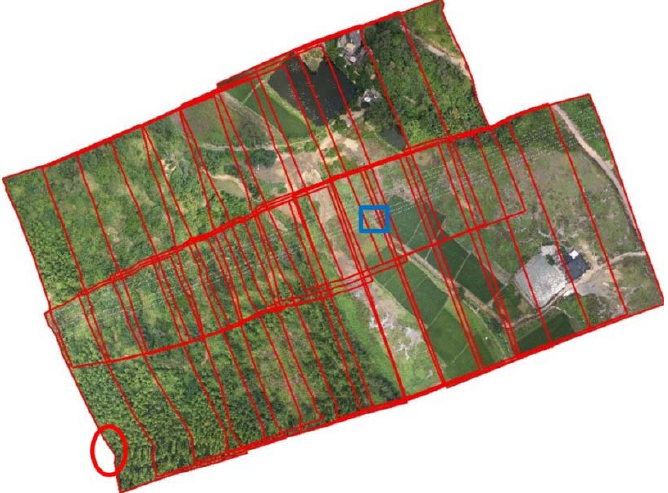
Figure 8. Data Set 2.